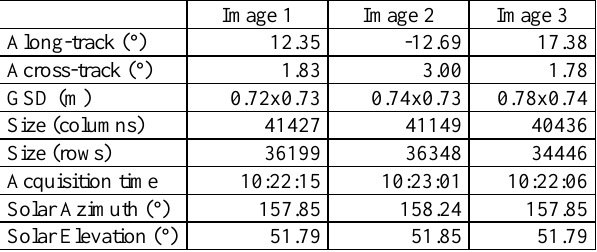
Fig. 1. Zoom in building area in the three Pleiades images over Trento, acquired with along-track acquisition angles 18° (left), - -13° (centre) and 13° (right). Table 1. Characteristics of Pléiades-1A panchromatic triplet.